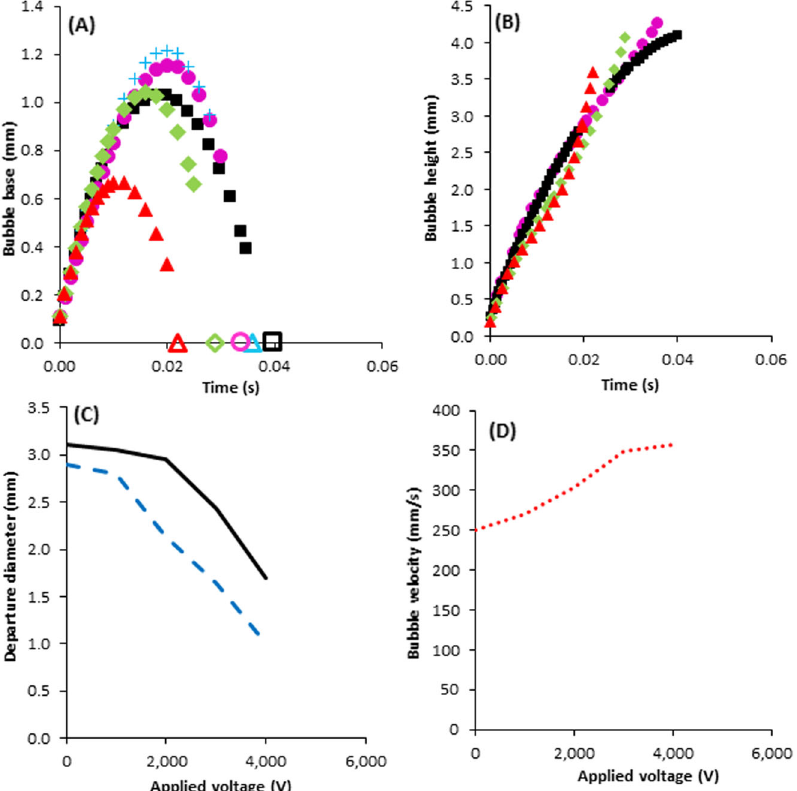
Fig. 4 Electrohydrodynamic force effect on the bubble speci fi cations. Electrohydrodynamic force effect on: The bubble base ( A ), height ( B ), diameter ( C ), and departure velocity ( D ). The legends for ( A ) and ( B ) 0V ( ), 1000V ( ), 2000 V ( ), 3000V ( ), 4000V ( ), the legends for ( C ) Tw-Tsat = 7°C ( ), and Tw-Tsat = 8.5°C ( ), and the legend for ( D ) Tw-Tsat = 8.5°C (